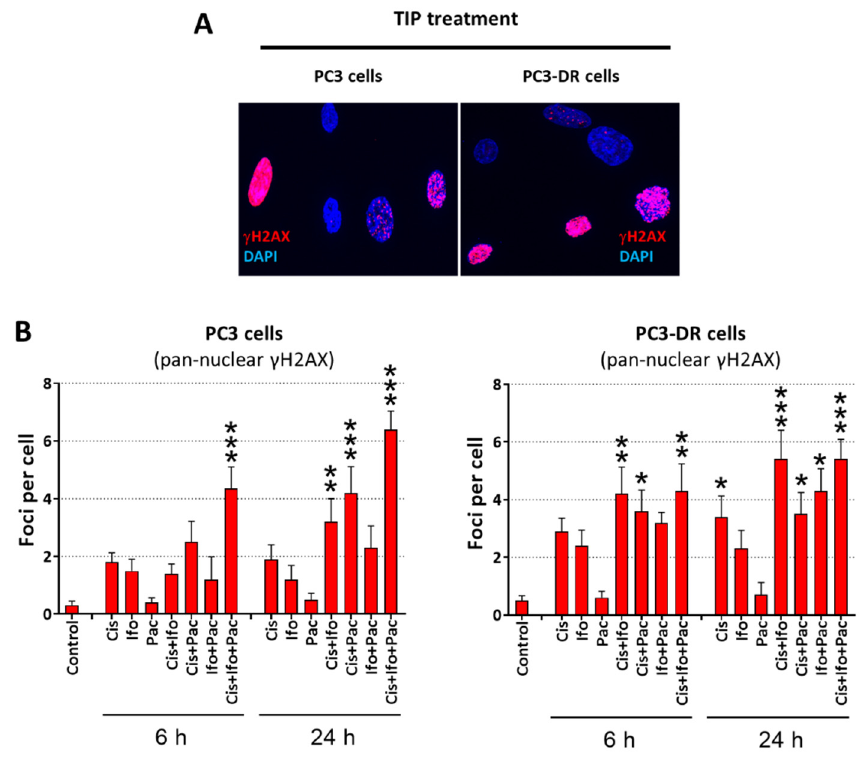
Figure 9. Evaluation of cells undergoing replication stress following the treatment. PC3 and PC3-DR cells were treated with the individual drugs at concentrations equal to their corresponding IC 50 s and their combinations for 6 h. A total of 6 h and 24 h following the treatment immunofluorescence staining for γ H2AX (red staining) and nuclei (DAPI, blue staining) was performed ( A ). Cells exhibiting a pan-nuclear γ H2AX signal were considered as those undergoing replication stress and were microscopically counted ( B ). Statistical analysis: difference between the sample and control: * p < 0.05; ** p < 0.01; *** p < 0.001 (ANOVA).